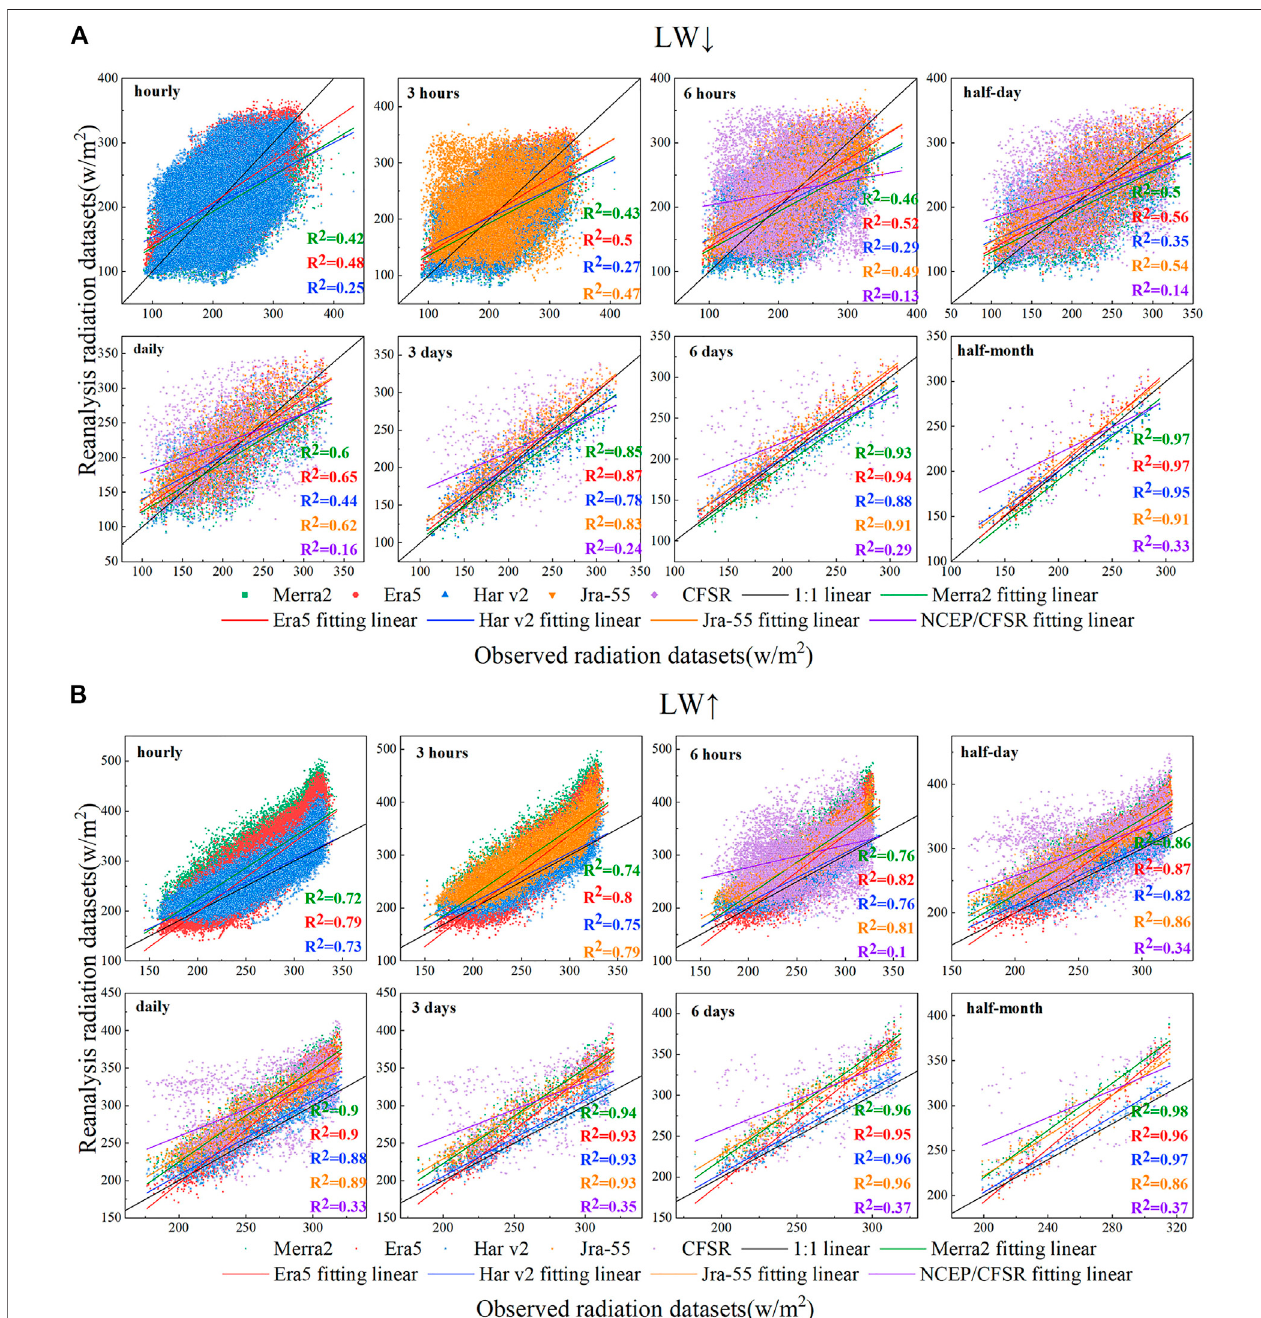
FIGURE 5 | 2010 – 2015 Scatter distribution of observed longwave radiation datasets and reanalysis datasets on different time scales; (A) and (B) represent downward longwave radiation and upward longwave radiation.